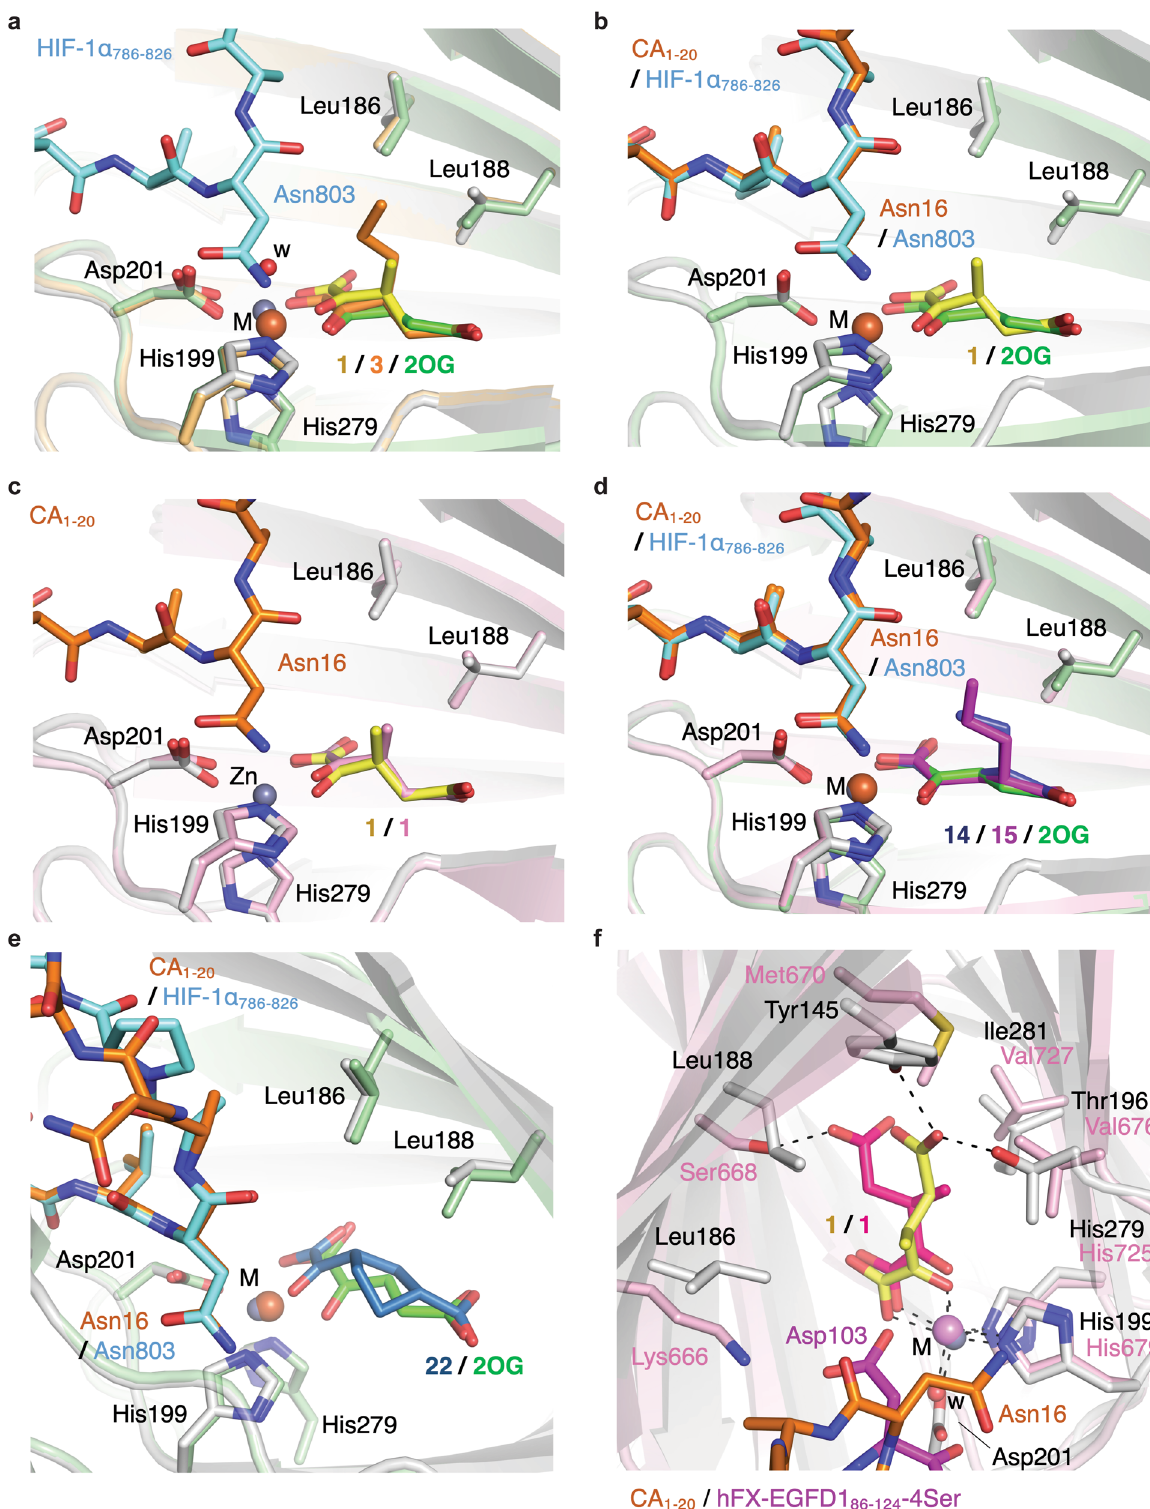
Synthetic 2OG derivatives inhibit FIH . To further